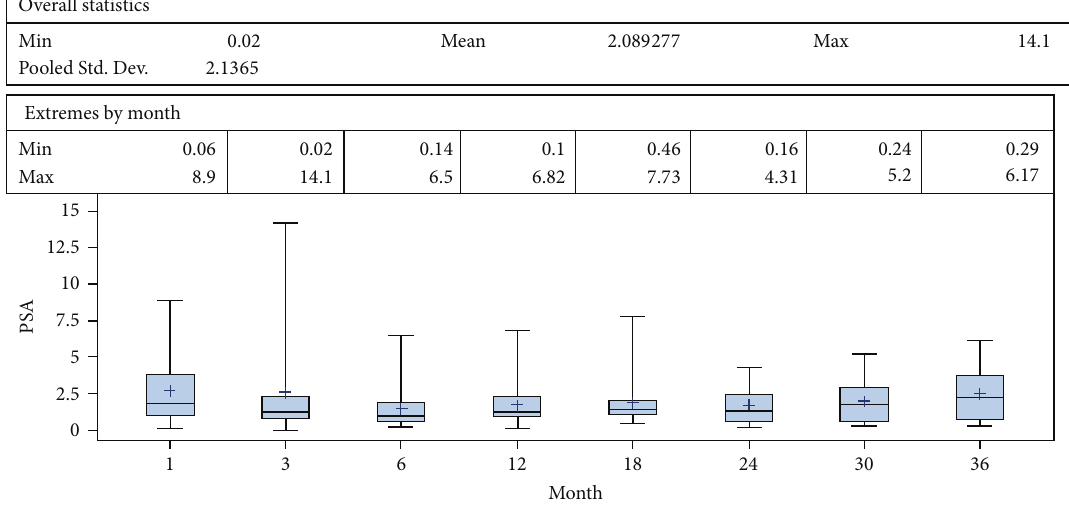
Figure 1: PSA dynamics during followup after hemi-HIFU treatment.